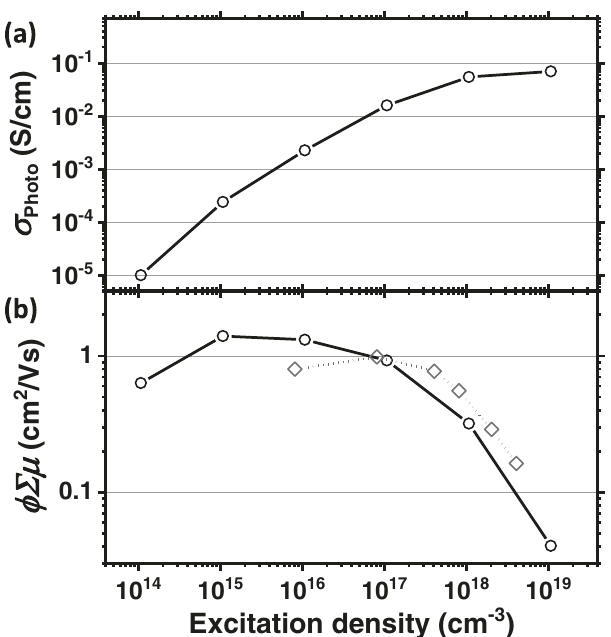
Fig. 2 Evaluation of excitation density-dependent optoelectronics properties of FACs perovskite thin fi lms. a σ Photo t ¼ 0 ð Þ calculated from the extrapolation as a function of excitation density (cm − 3 ). b Charge carrier mobility ( ϕ ∑ μ , sum-of-mobilities of electron and hole) determined by TPC and TRMC (for circle and diamond, respectively, lines are only to guide the eyes) as a function of excitation density (cm − 3 ). For TPC, the σ Photo t ¼ 0 ð Þ is used for Eq. 4, ( σ Photo t ¼ 0 ð Þ ¼ eI Tot ϕΣμ ). The charge carrier mobilities ( ϕ ∑ μ ) from both measurements are in a good agreement for the entire range of excitation